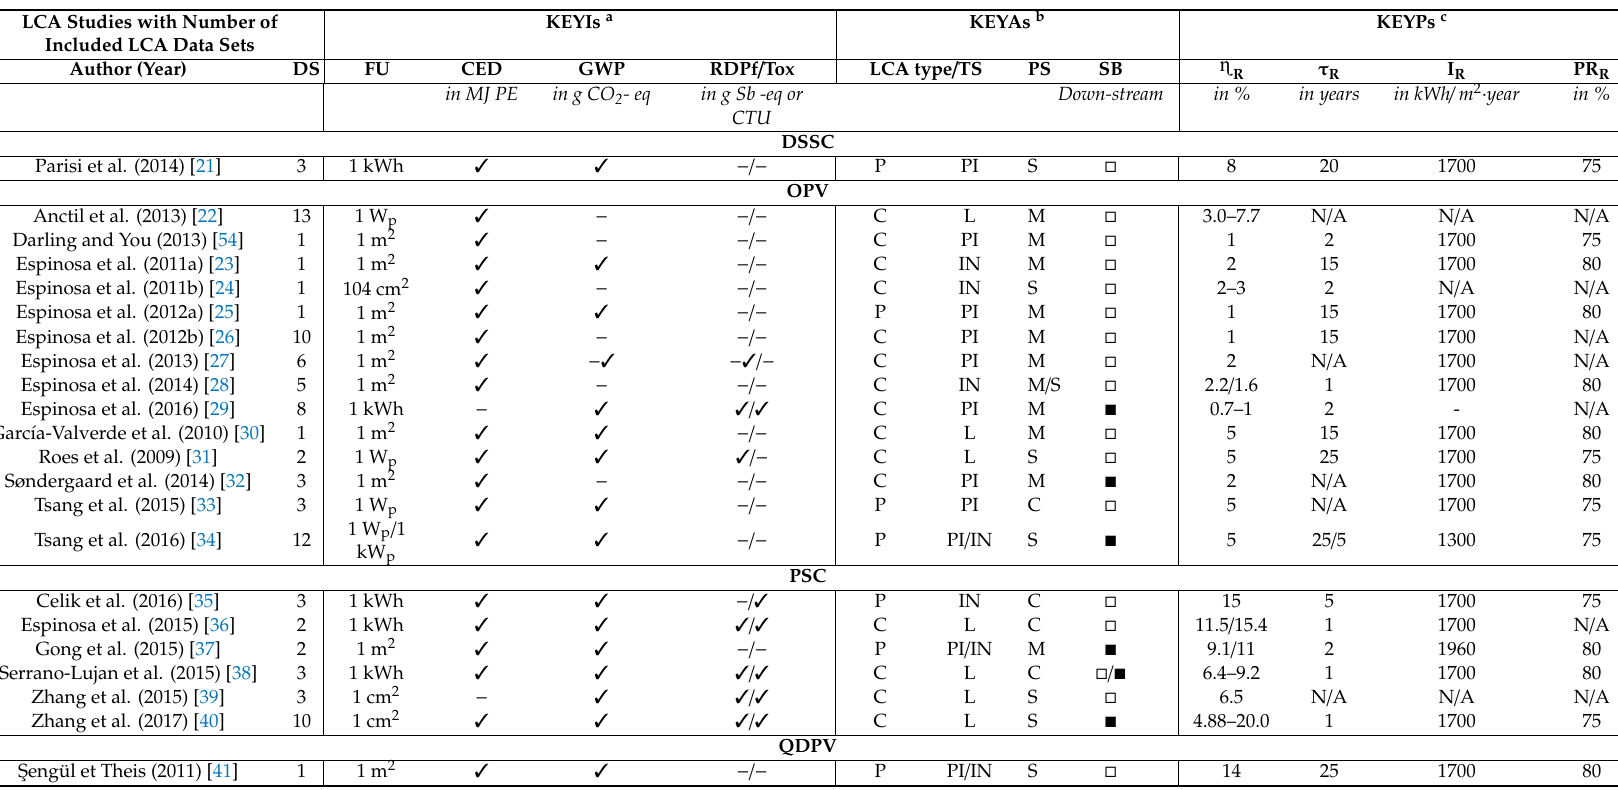
Table 2. Reviewed LCA studies with number of data sets on DSSC, OPV, PSC, and QDPV (22 studies, 94 LCA datasets), considered key indicators (KEYIs) with corresponding functional unit, key modeling assumptions (KEYAs) and assumptions on the four key performance parameters (KEYPs). LCA Studies with Number of Included LCA Data Sets